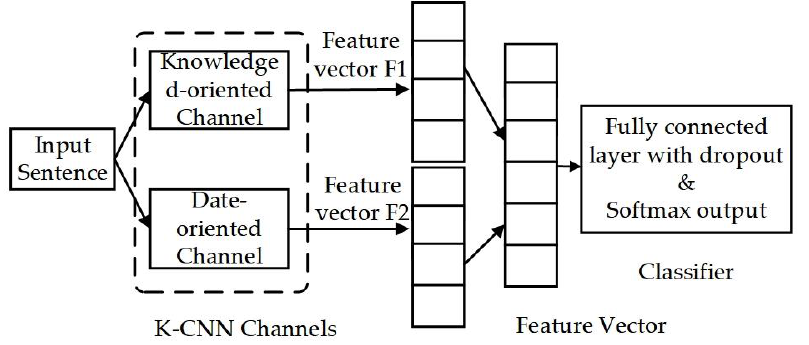
Figure 2. The overall architecture of K-CNN, which contains two collaborative channels, including knowledge-oriented channels and data-oriented channels, combines both prior human knowledge and the information derived from data in a complementary manner to extract causality from natural language texts